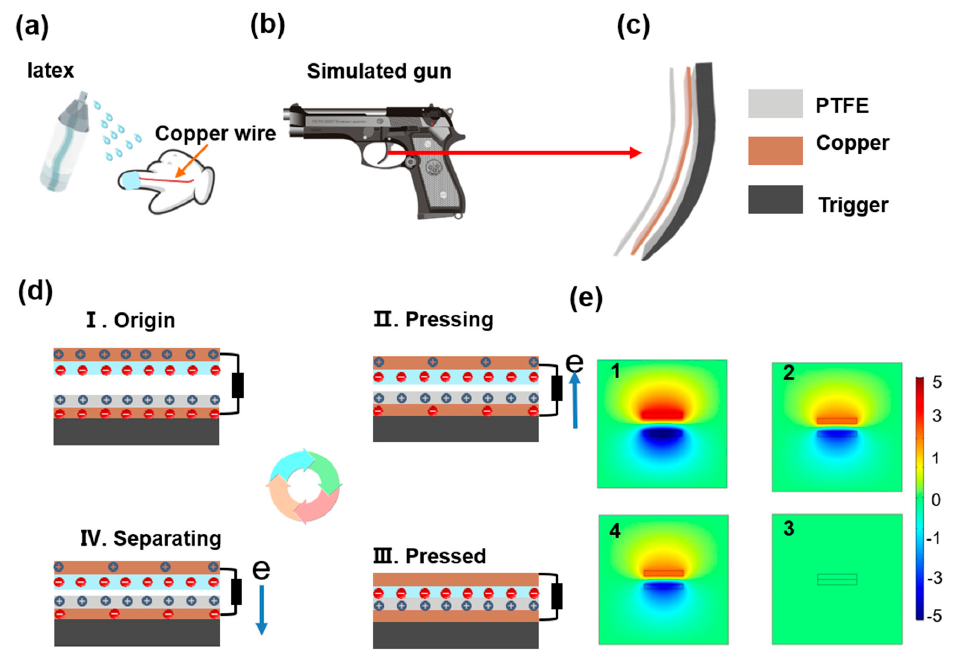
Figure 2. The manufacturing process and working mechanism. ( a ) Manufacturing process of SPTENG; ( b ) Attachment position of PTFE and simulation pistol; ( c ) Detail diagram of trigger; ( d ) Working mechanism of SPTENG; ( e ) COMSOL potential simulation diagram.